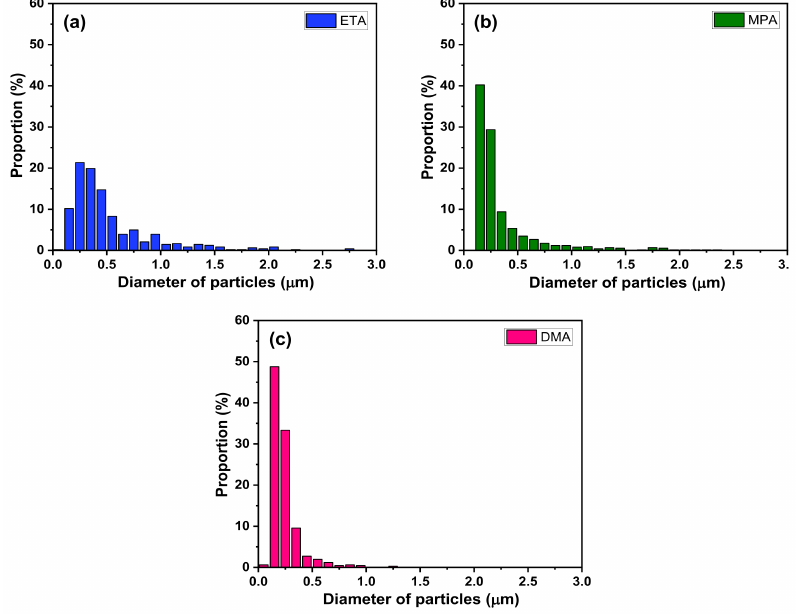
Figure 7. Particle size distribution of magnetite particles using an image analyzer: ( a ) ETA, ( b ) MPA, and ( c ) DMA.